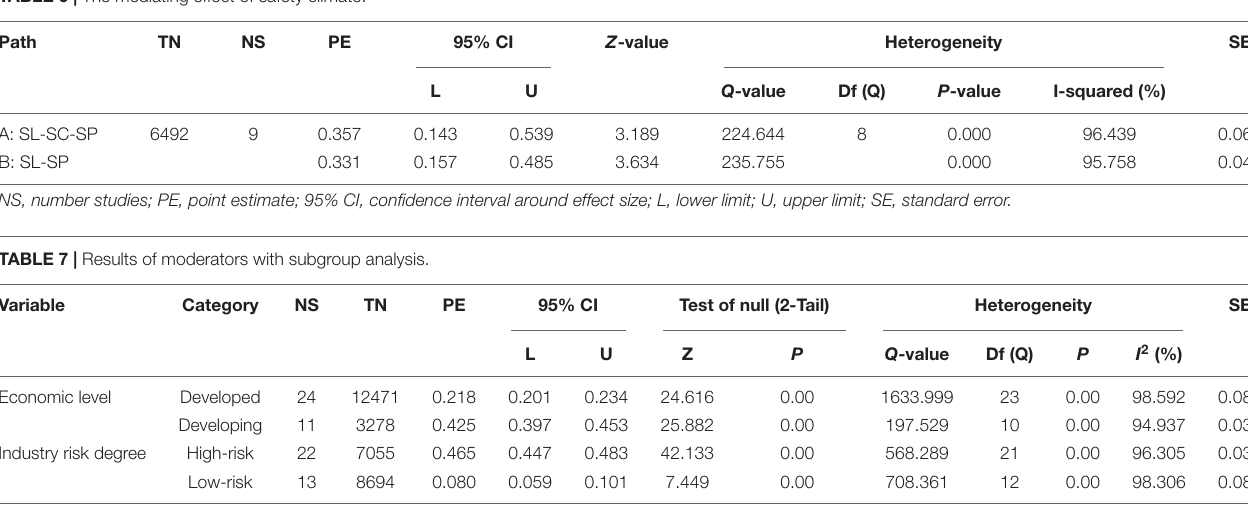
TABLE 6 | The mediating effect of safety climate.